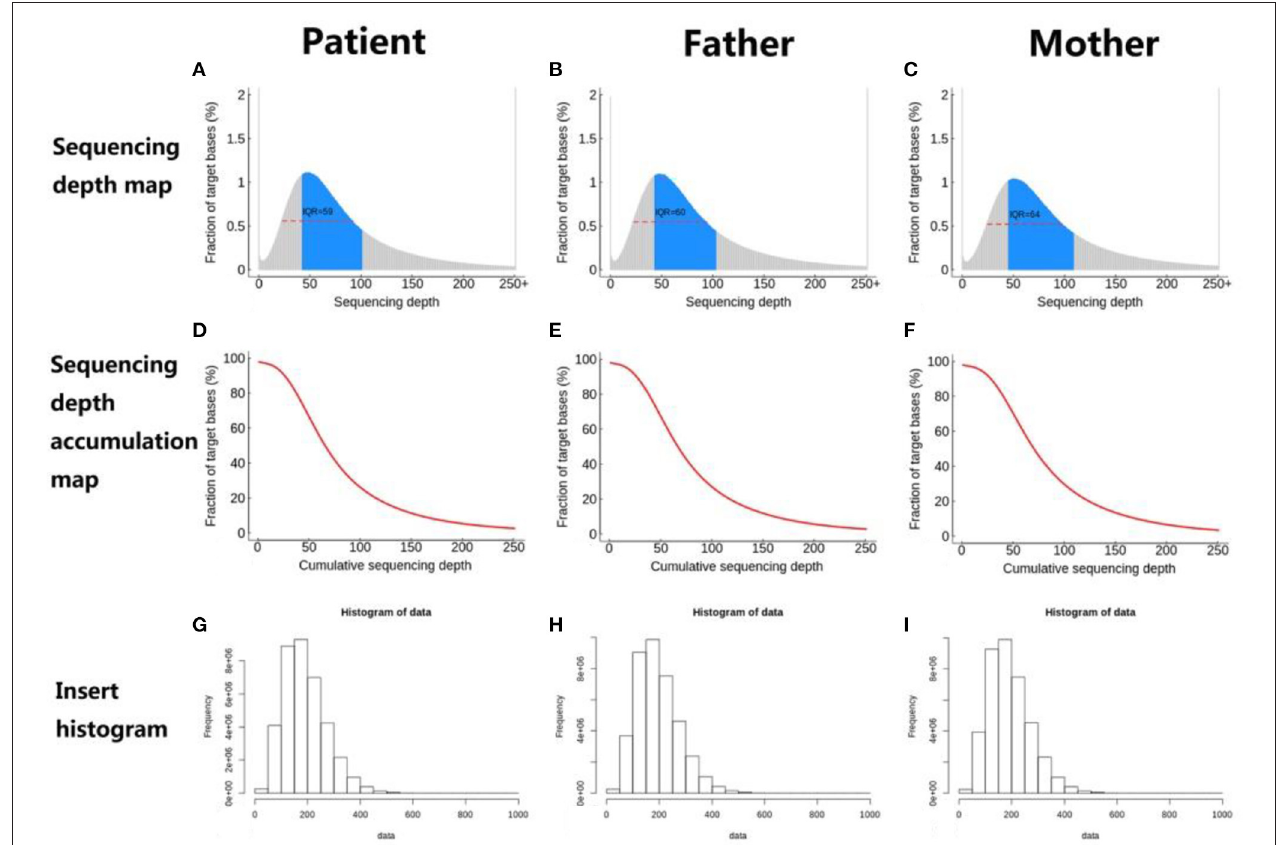
FIGURE 7 | (A96I) Sequencing coverage